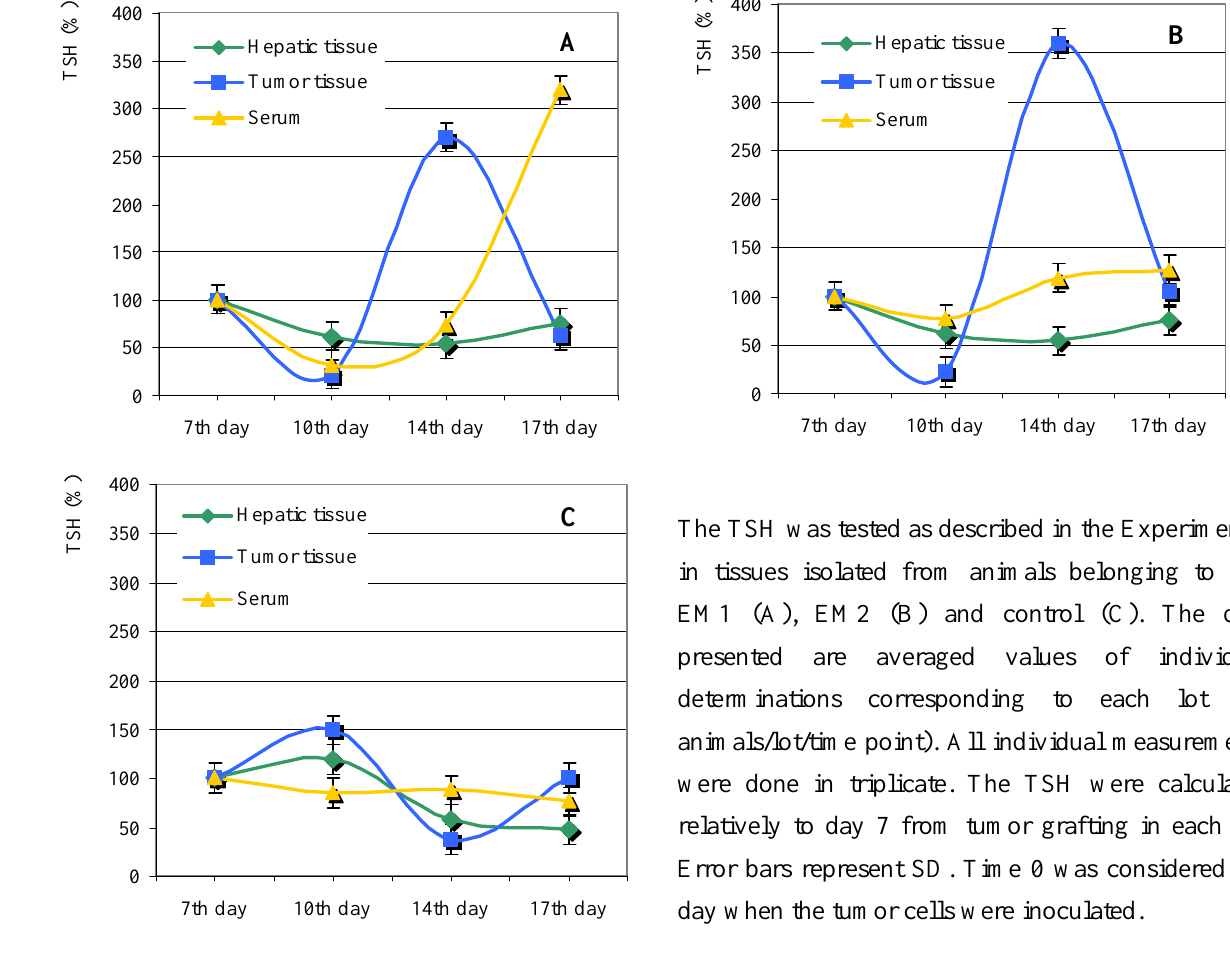
animals/lot/time point). All individual measurements were done in triplicate. The TSH were calculated relatively to day 7 from tumor grafting in each lot. Error bars represent SD. Time 0 was considered the day when the tumor cells were